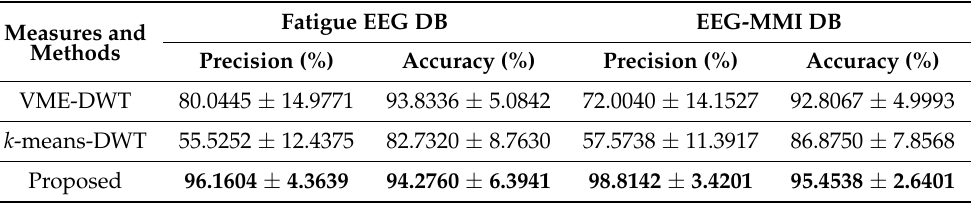
Table 2. Comparison of precision and accuracy ( µ ± σ ) of the proposed method with existing methods for eye-blink detection on two real EEG